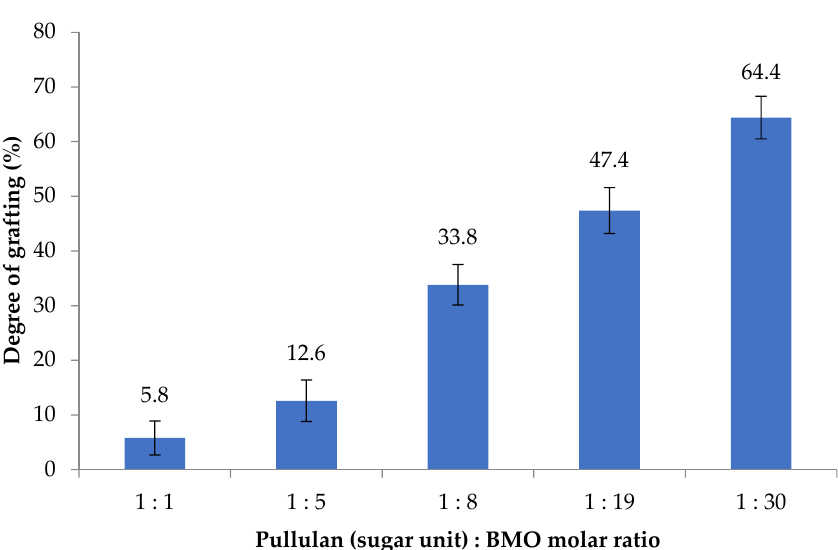
Figure 4. The effect of reagent ratio on the grafting degree ( n = 3; ± SD).